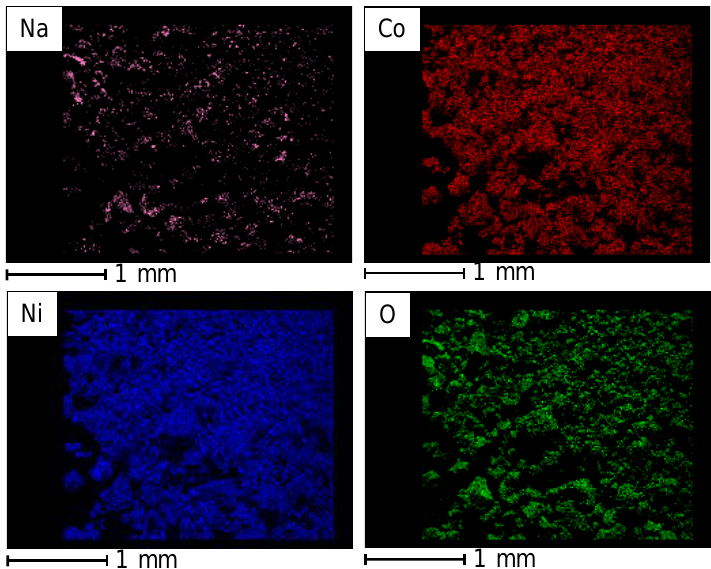
Figure 4. EDX mapping relative to sample NiCo_2.